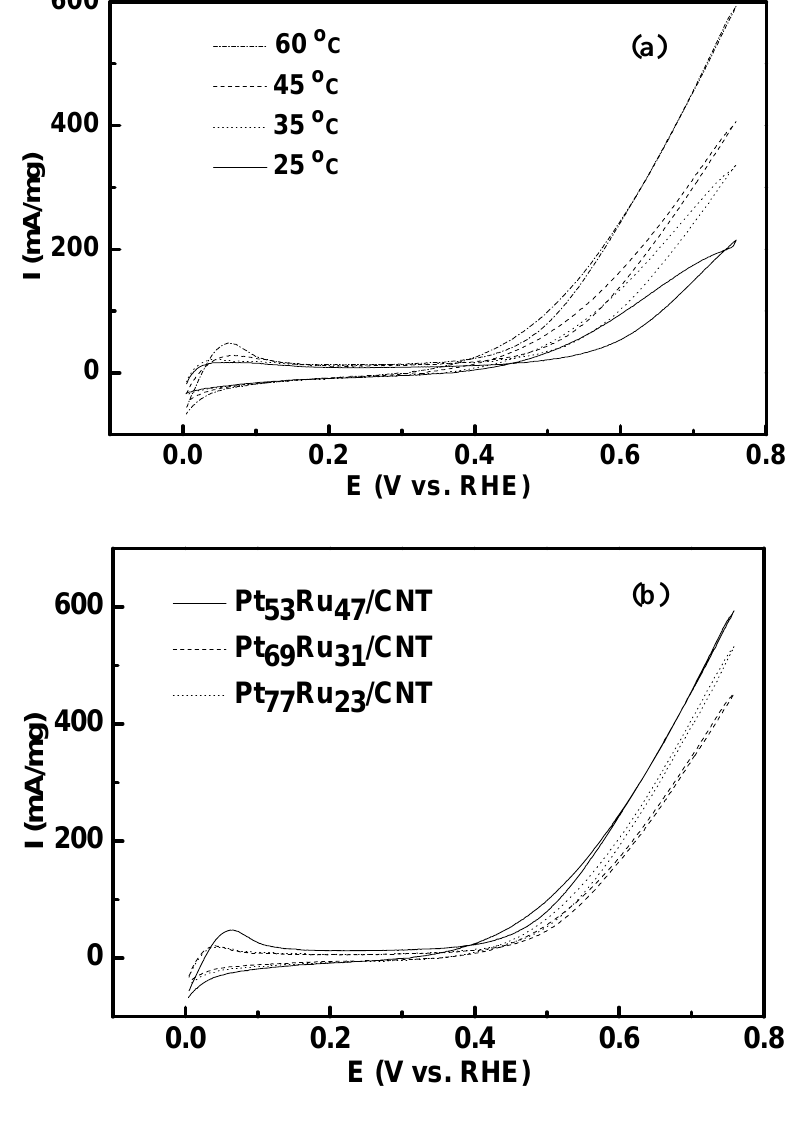
Figure 1. (a) Cyclic voltammograms of methanol electro-oxidation on Pt elevated temperatures. (b) Cyclic voltammograms of methanol electro-oxidation on different PtRu/CNT catalysts at 60